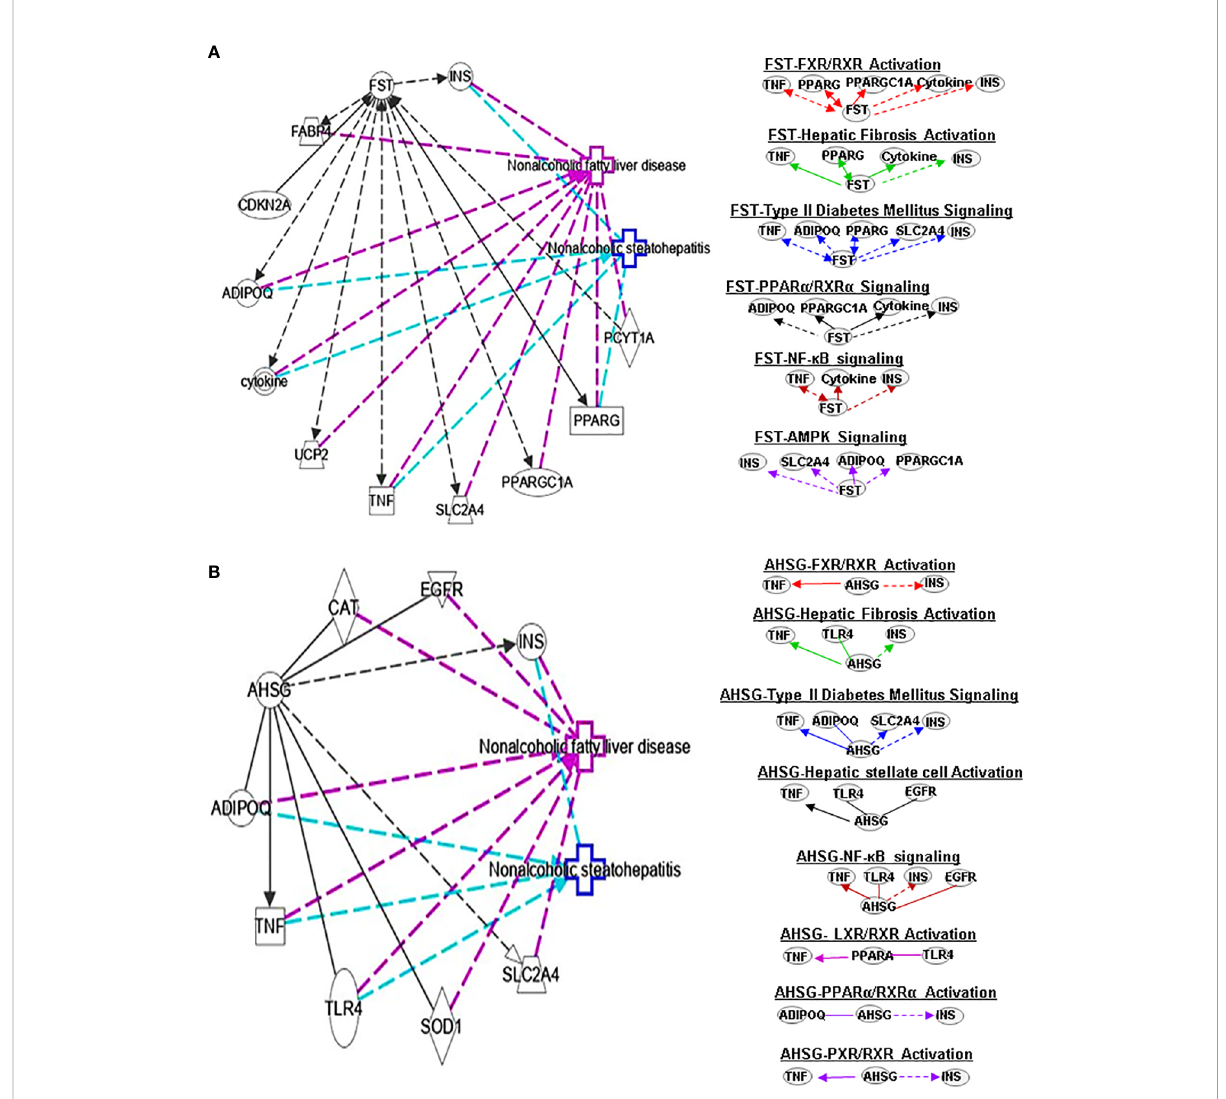
FIGURE 3 Ingenuity pathway analysis (IPA) of FST and AHSG. (A) IPA investigated the molecular pathways of FST involved in NAFLD and NASH. All identi fi ed pathways of FST were screened individually. Representative canonical pathways of FST are associated with other related genes and molecules of NAFLD and NASH. Functional relationships of these genes, molecules and FST are depicted using straight lines with arrows. FST is functionally related to 1. FXR/RXR signaling; 2. Hepatic fi brosis signaling; 3. Type 2 Diabetes Mellitus signaling; 4. PPAR a /RXR a signaling; 5. AMPK signaling and 6. NF k B signaling (Right). (B) IPA investigated the molecular pathways of AHSG involved in NAFLD and NASH. All identi fi ed pathways of AHSG were screened individually (left). Representative canonical pathways of AHSG are associated with other related genes and molecules of NAFLD and NASH. Functional relationships of these genes and AHSG are depicted using straight lines with arrows. AHSG is functionally related to 1. FXR/RXR signaling; 2. Type 2 Diabetes Mellitus signaling; 3. Hepatic stellate cell activation signaling; 4. NF- k B signaling; 5. LXR/RXR signaling; 6. PPAR a /RXR a signaling and 7. PXR/RXR signaling (Right). Solid lines show direct regulation while dotted lines depict indirect interactions. PPARGC1A, Peroxisome proliferator-activated receptor gamma coactivator